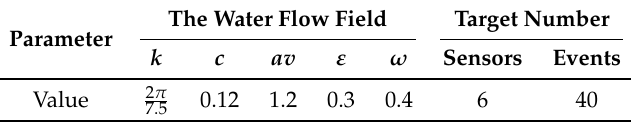
Table 2. Parameters of the dynamic ocean